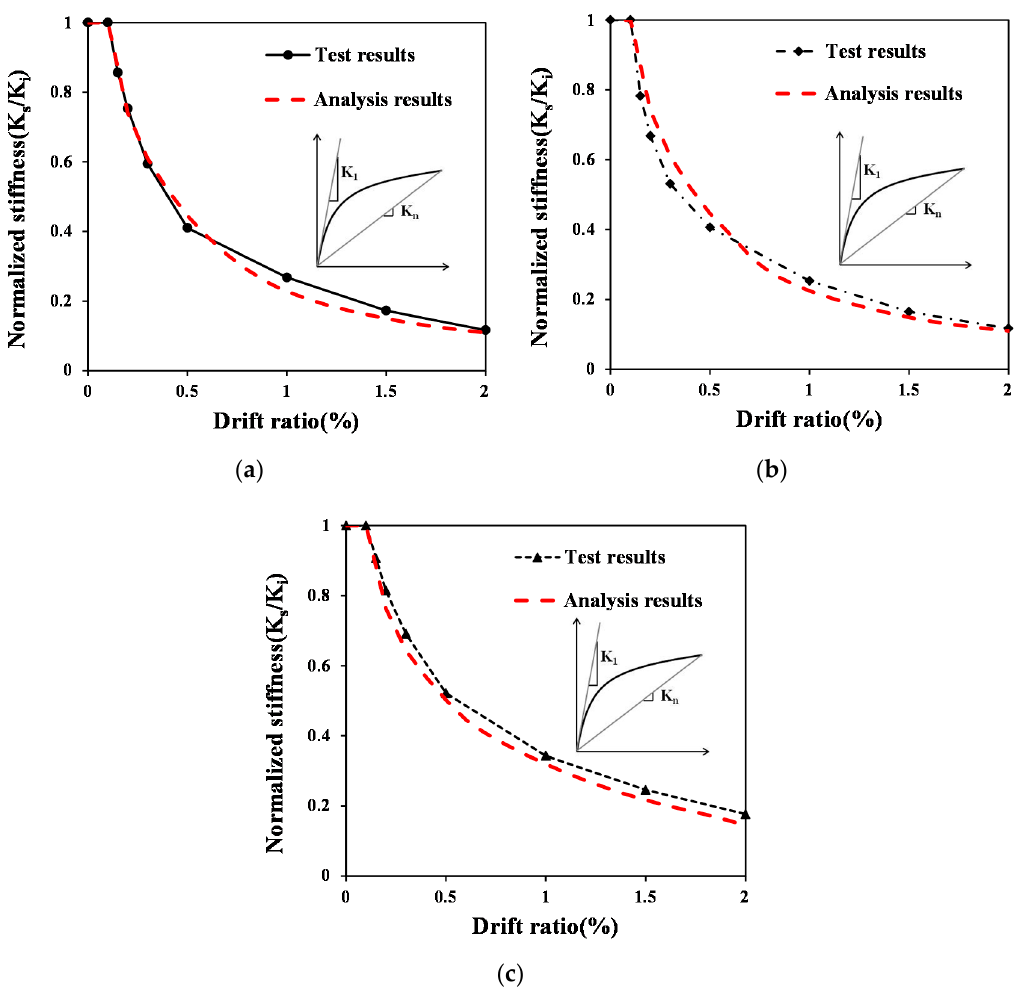
Figure 14. Measured and estimated normalized stiffness: ( a ) Specimen FB; ( b ) Specimen FBC; ( c ) Specimen FPB.